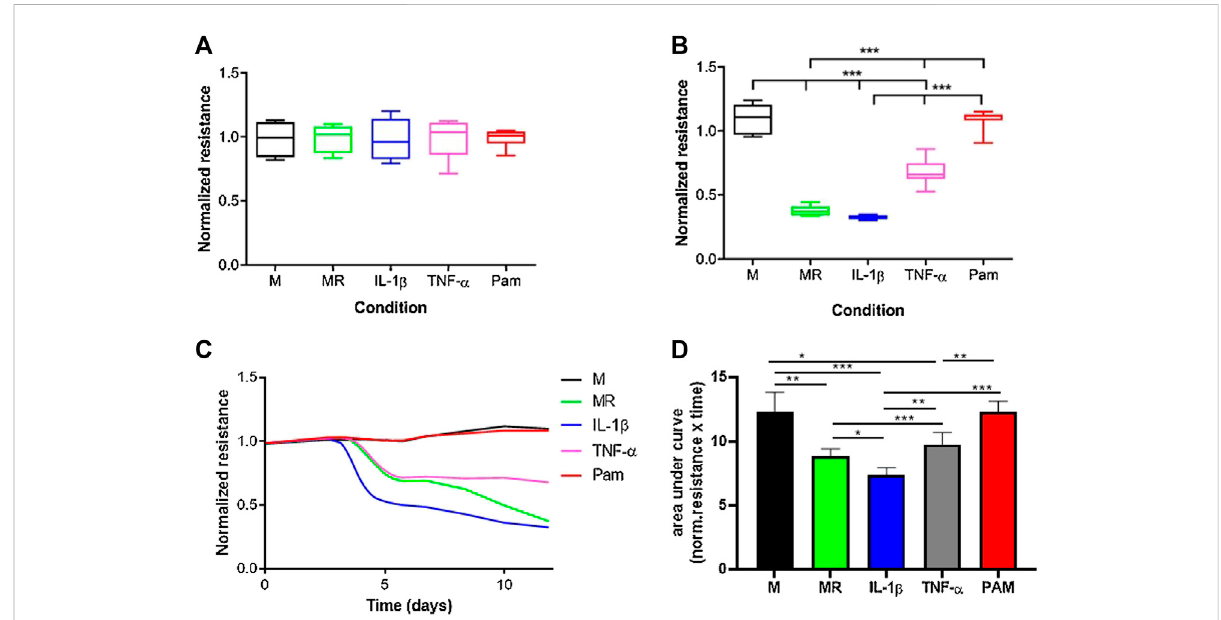
Real-time resorption quanti fi cation provides mechanistic insights into osteoclast formation and resorptive activity. M = medium with M-CSF, MR = medium with M-CSF and RANKL, IL = medium with M-CSF, RANKL and IL-1 β , TNF- α = medium with M-CSF and RANKL and TNF- α , PAM = medium with M-CSF and RANKL and Pamidronate. Osteoclasts were generated from mouse bone marrow, and the resistance was measured for 11 days. (A) . No differences in resistance were found between the various conditions at timepoint zero since pre-osteoclasts were not differentiated into mature cells yet. (B) . After 11 days of culture, osteoclasts were formed and CAP coating was lysed, resulting in differences in resistance. Osteoclasts were formed in cultures with MR, IL-1 β , and TNF- α , resulting in a lower resistance due to lysis of the CAP coating. In the cultureswithonlyMorPam,noactiveosteoclastswerepresentandnodeclineinresistancewasrecorded.(one-wayANOVAn=6,*** p < 0.05). (C) . Overview of the resistance from day 0 to day 11. Typical for the lysis of CAP coating is the lag phase between days 0 – 4, where the resistance is not changed. Thus, no lysis has taken place because osteoclasts were not formed yet. From day 4, unique CAP lysis patterns emerge, likely due to differential activation of osteoclasts by MR supplemented with or without IL-1 β or TNF- α , all leading to lower resistance. In the M and PAM cultures, no lysis occurred, likely due to the absence of osteoclasts, resulting in no change in resistance. (D) . Quanti fi cation of area under the curve shows signi fi cantdifferences(* p < 0.01,** p < 0.001,and*** p < 0.0001n=6)formostoftheincubations.Onlytheincubationsinwhichnoosteoclastswere formed (M and PAM) show an equally high area under the curve. The incubation with IL-1 β has the smallest area, which means that CAP lysis was the